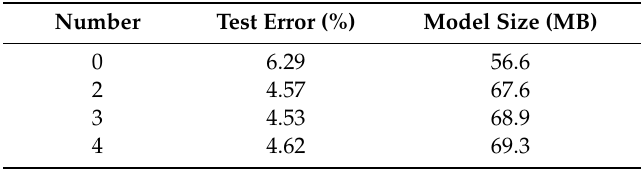
Table 6. E ff ect of using a di ff erent number of bridge Table 6. Effect of using a different number of bridge connections.